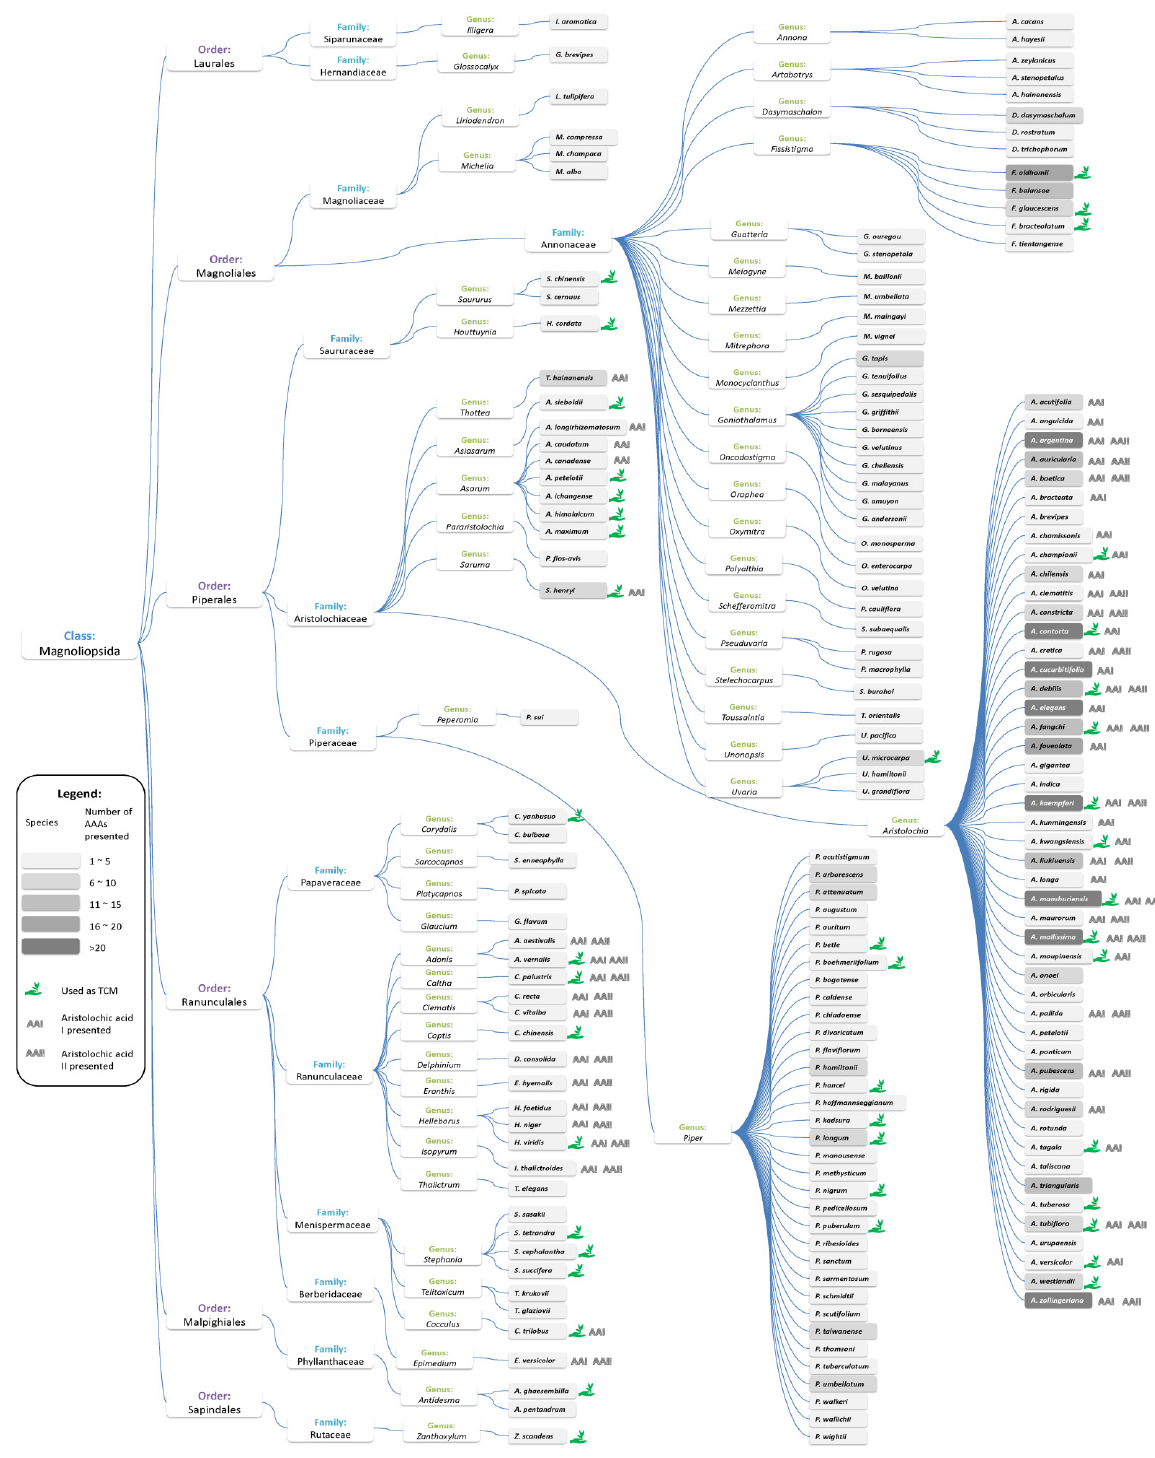
Figure 5. The taxonomic distribution of species containing aristolochic acid analogues. High-resolution image file of this Figure can be found in Supplementary Materials as Figure S3.